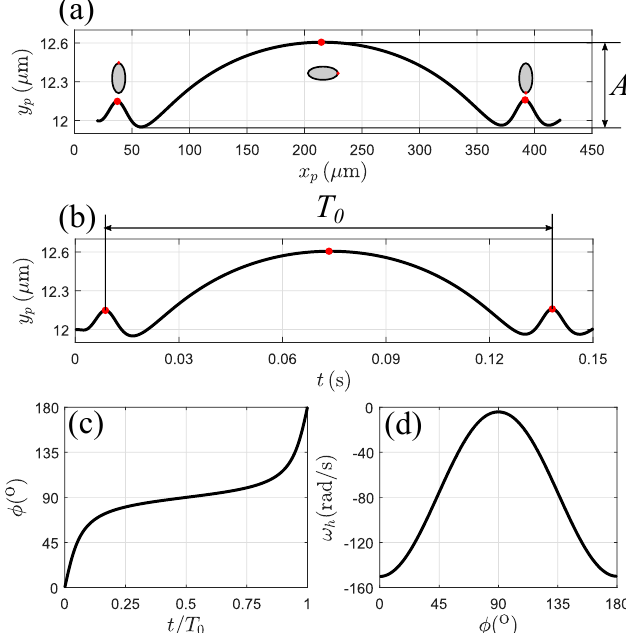
Figure 4. Translation and rotation of the particle without a magnetic field. The particle ( AR = 4) is initially located at y p 0 = 12 µ m. ( a ) trajectory of the particle over a rotation of 180 ◦ , with A denoting the amplitude of oscillatory motion; ( b ) the particle–wall separation distance over one period T 0 ; ( c ) the evolution of orientation angle, φ with the dimensionless time t / T 0 ; and ( d ) the rotational velocity ω h versus φ